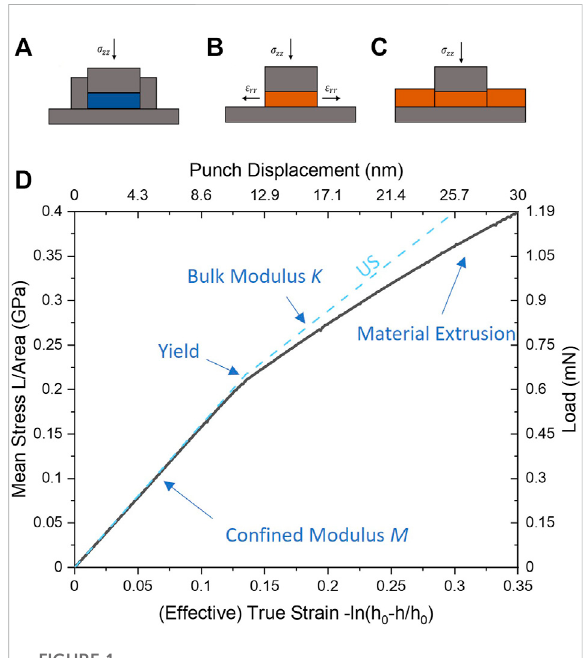
Comparative schematic of (A) pure uniaxial strain (US) with rigid wall and substrate con fi nement, vs. (B) uncon fi ned fl at punch puck compression vs. (C) theLayerCompressionTest (LCT)where the surrounding fi lm provides a con fi ning sidewall effect on a puck-like region. In (D) a simulation of the LCT (black line) is compared to the theoretical expectation of uniaxial strain (blue dotted line) for a contact aspect ratio of α = 20 and elastic-plastic fi lm with E = 1 GPa, ν = 0.35, Y = 0.1 GPa on substrate with modulus 500 GPa (S = 500). An initial linear region in the stress strain curve corresponds to elastic deformation (slope M, the con fi ned Modulus), followed by a sudden change of slope at the con fi ned yield point Y c to con fi ned elastic-plastic deformation with slope K , the bulk modulus. Strains in the LCT curve past the yield point shows increasing deviation from pure uniaxial strain due to failure of the con fi ning fi lm material and associated